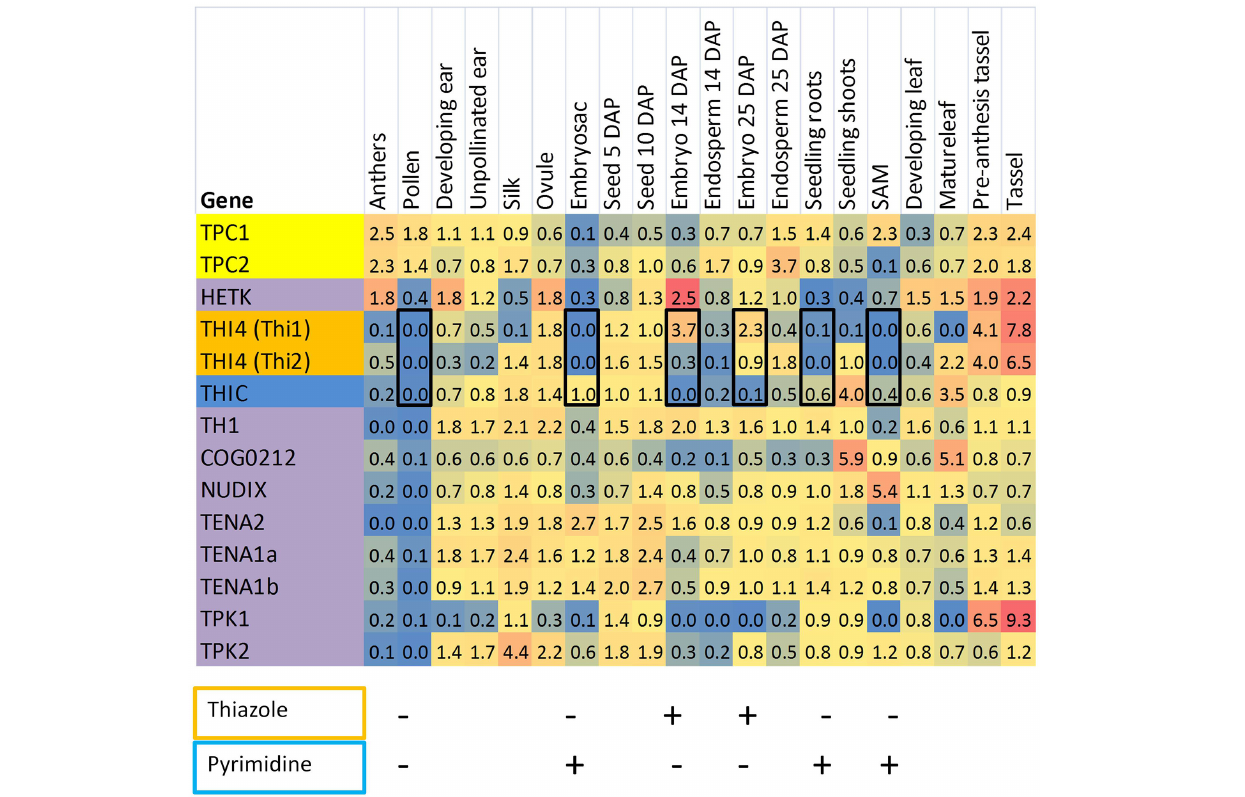
Other genes involved in thiamin assembly and salvage are colored purple, and mitochondrial transporter genes are highlighted in yellow. Black rectangles highlight six developmental contexts that show either low expression or divergent expression of genes encoding THIC and THI4. For these cases, qualitative patterns of thiazole (outlined in gold) and pyrimidine (outlined in blue) biosynthetic capacity are summarized as being present (+) or low/absent (–). SAM, shoot apical